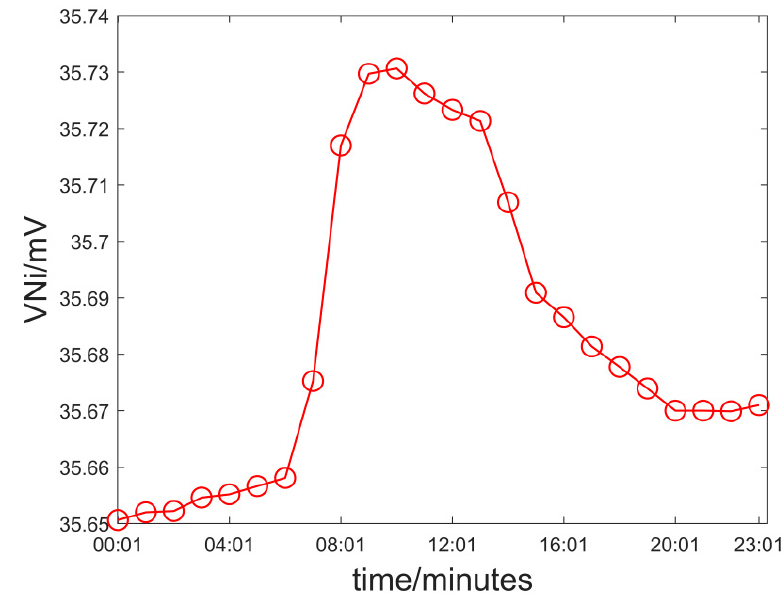
results of the blackbody after receiver gain error calibration. It can be seen from the figure that the error of measurement of the blackbody after receiver gain calibration is reduced by nearly 1 K at the maximum fluctuation of gain.